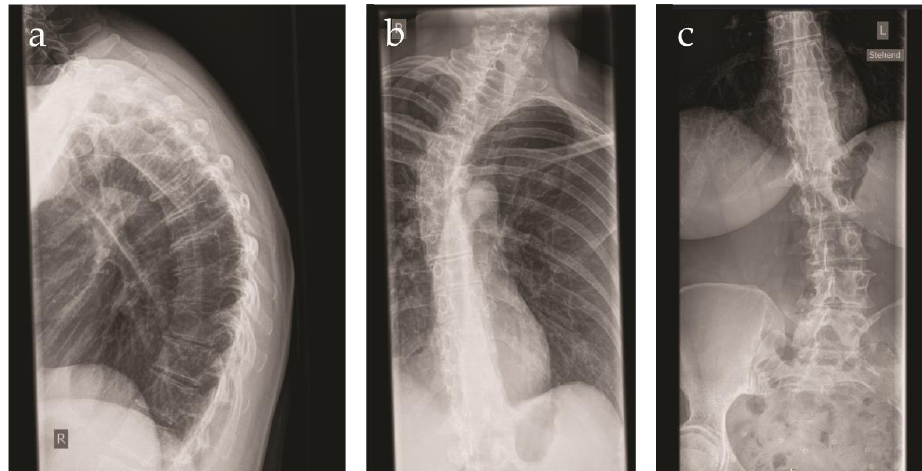
Figure 1. X-ray images of the vertebral column of the patient at the age of 41 years. ( a ) Side view demonstrating the pronounced kyphosis; ( b ) close-up of the pronounced cervical and thoracic scoliosis; ( c ) close-up of the lumbar scoliosis.